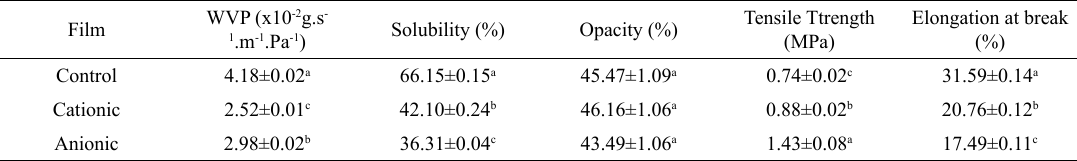
Table 1. WVP, solubility, opacity and mechanical properties of the films.